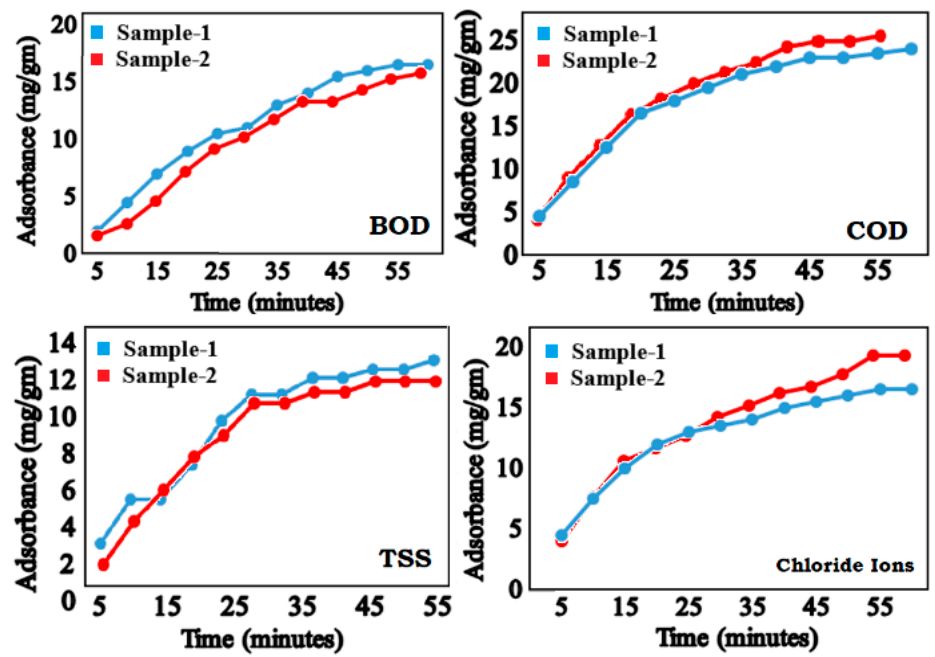
Figure 7. Adsorption concentrations (mg/gm) of BOD (pH-10), COD (pH-12), TSS (pH-10), and chlorides ions (pH-10) in samples-1 and -2 at different time intervals.